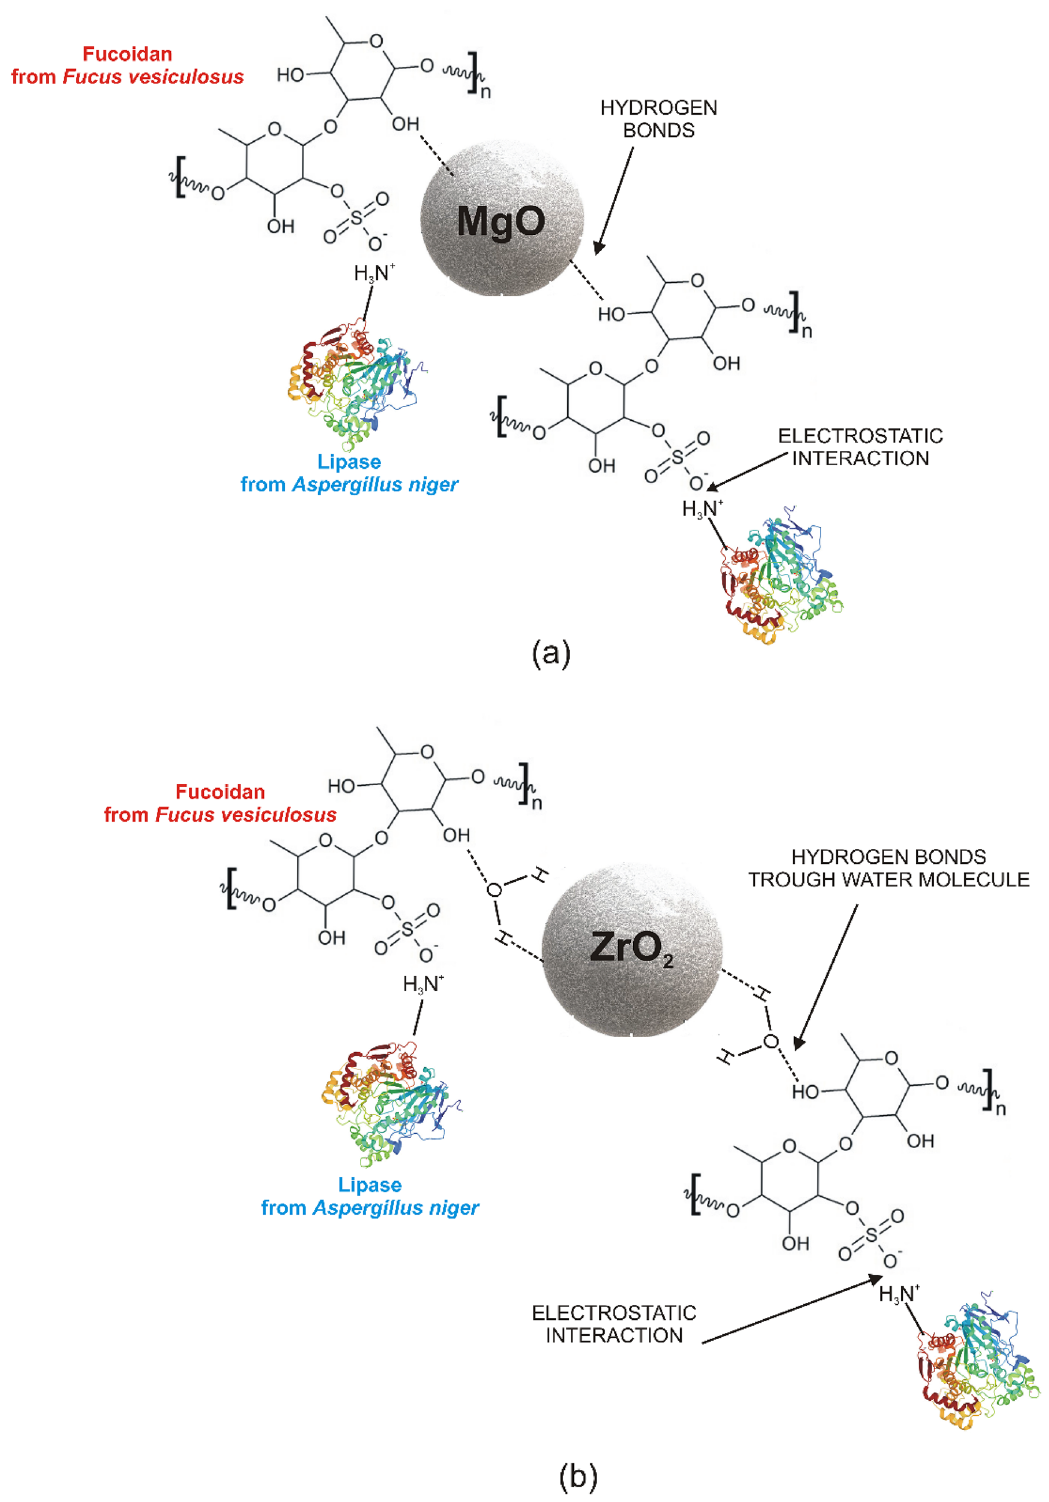
Figure 9. Proposed mechanism of interaction between the oxide support: MgO ( a ) and ZrO 2 ( b ), fucoidan, and